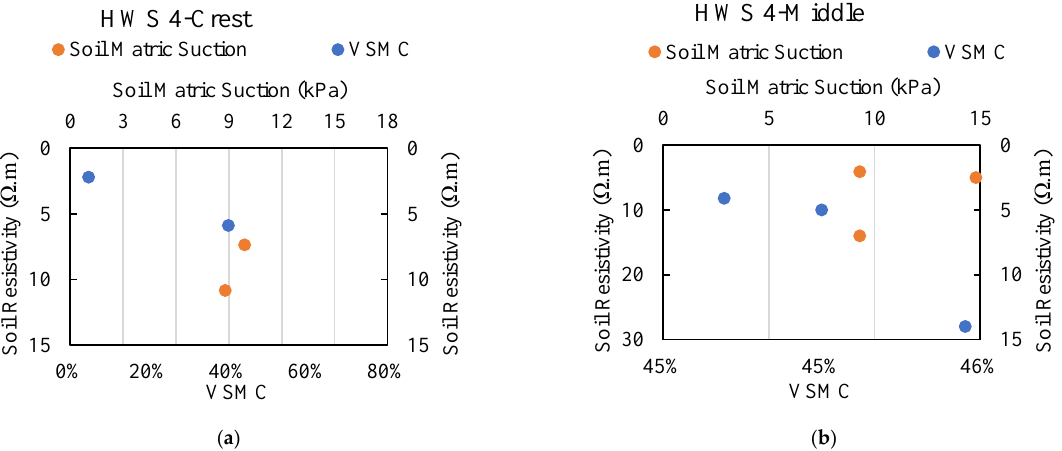
Figure 23. HWS 4 comparison of 2D ERI test profile with field instrumentation ( a ) At crest of the slope ( b ) At middle of the slope (1 m = 3.28 ft; 1 mm = 0.039 in; 1 kPa = 20.89 psf).